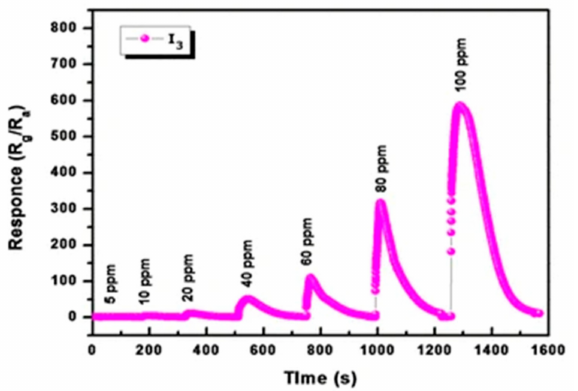
Figure 22. Sensor response of In 2 O 3 film at various concentrations of NO 2 . Reprinted from Ref. [197] with permission of Springer Science Business Media, LLC, 2018.